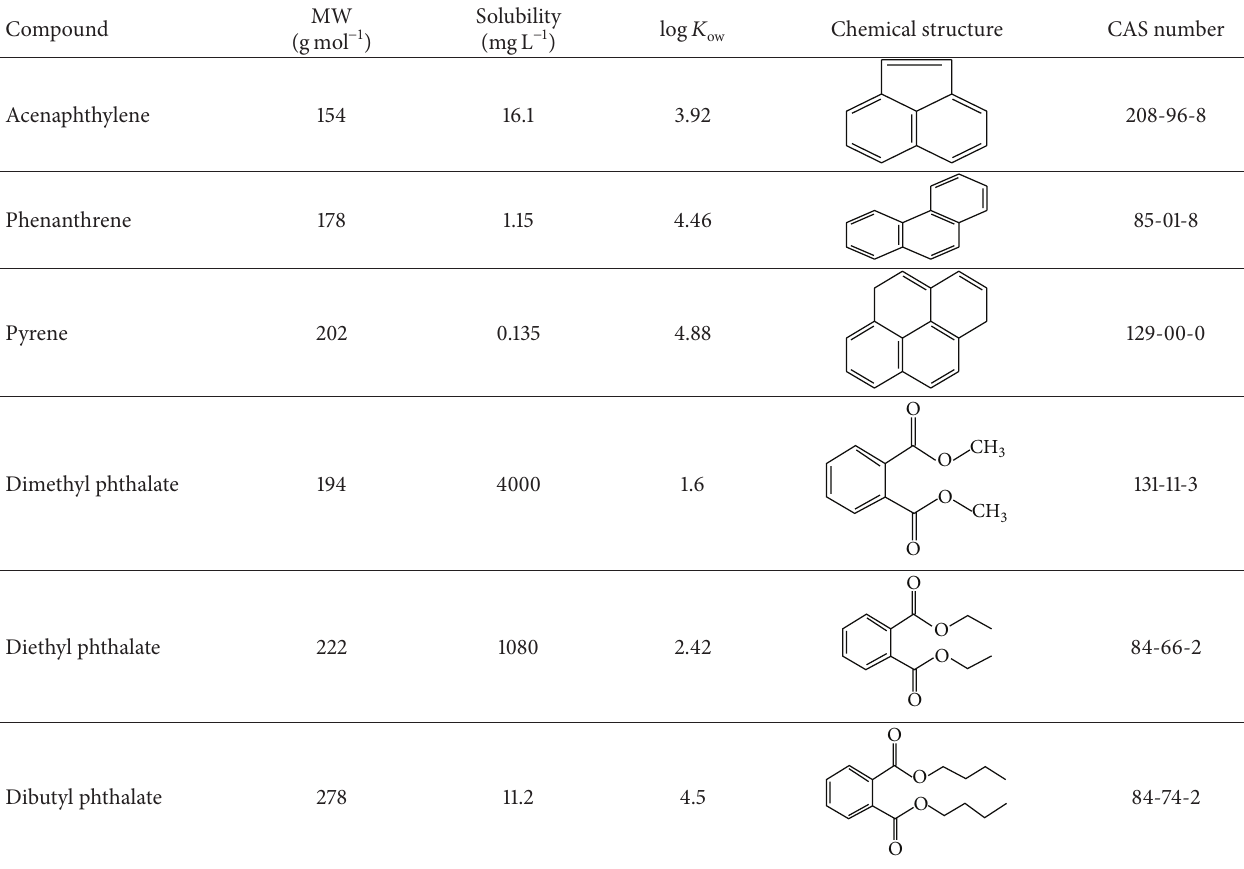
Table 1: Physicochemical properties of the compounds tested in this